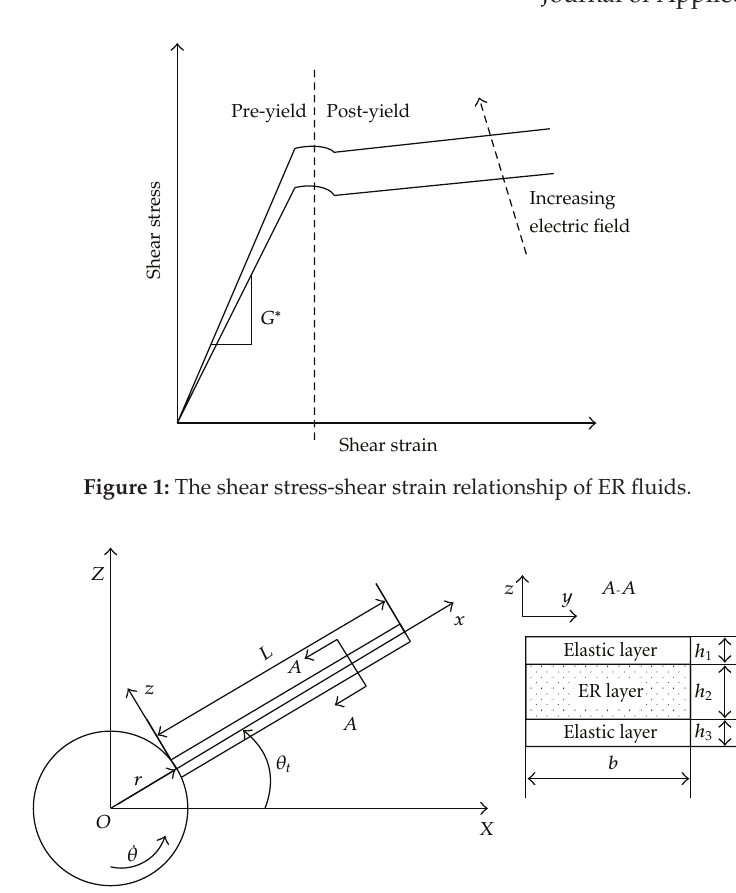
Figure 2: Rotating sandwich beam filled with ER fluid